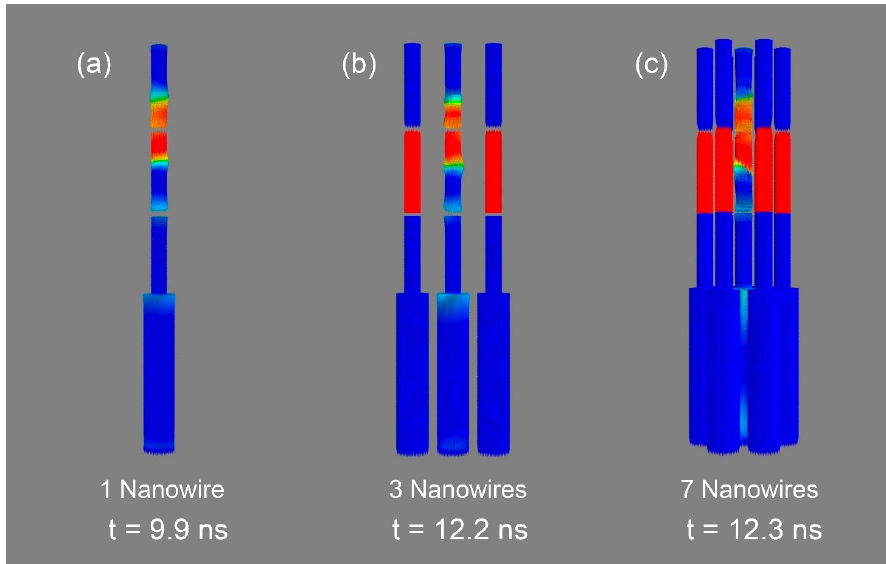
Figure 5. 3D representations of the bit movement in ( a ) a single nanowire and in the central wire of an array with ( b ) 3 and ( c ) 7 nanowires. The time indicated in each case corresponds to the time elapsed since the current pulse started.